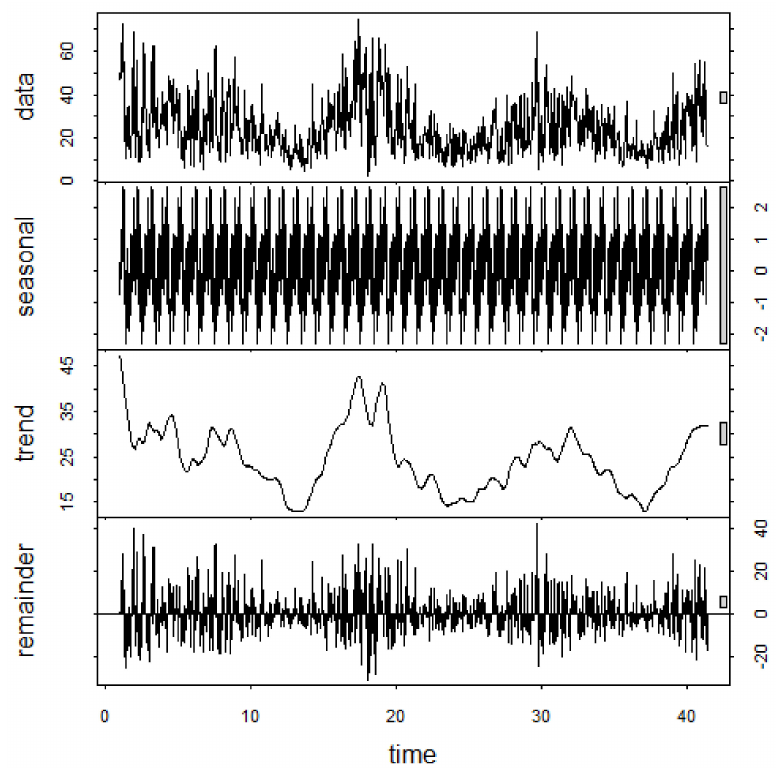
Figure 4. Three additive components obtained from seasonal-trend decomposition based on loess (STL), decomposition of NO 2 concentration ( µ g/m 3 ) collected at the Devonshire Green AQMS,